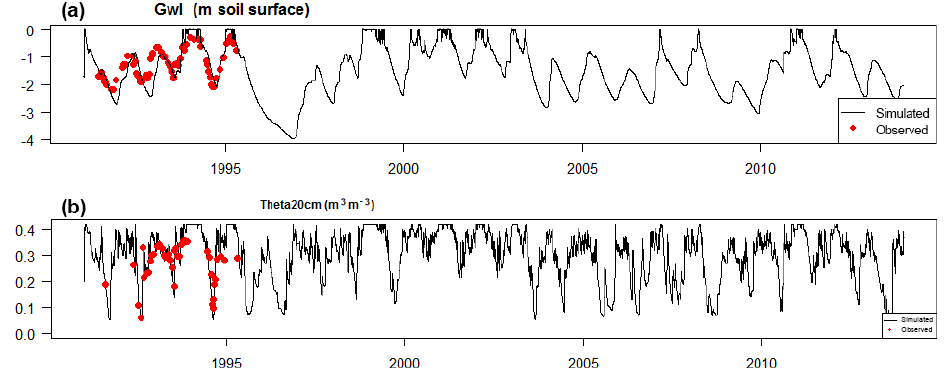
Figure 4. Results of case studies for grassland at location 1 (De Marke): (a) for groundwater level (Gwl in metres soil surface); (b) for soil moisture content (Theta20cm in m 3 m − 3 ) at 20cm below the soil surface.